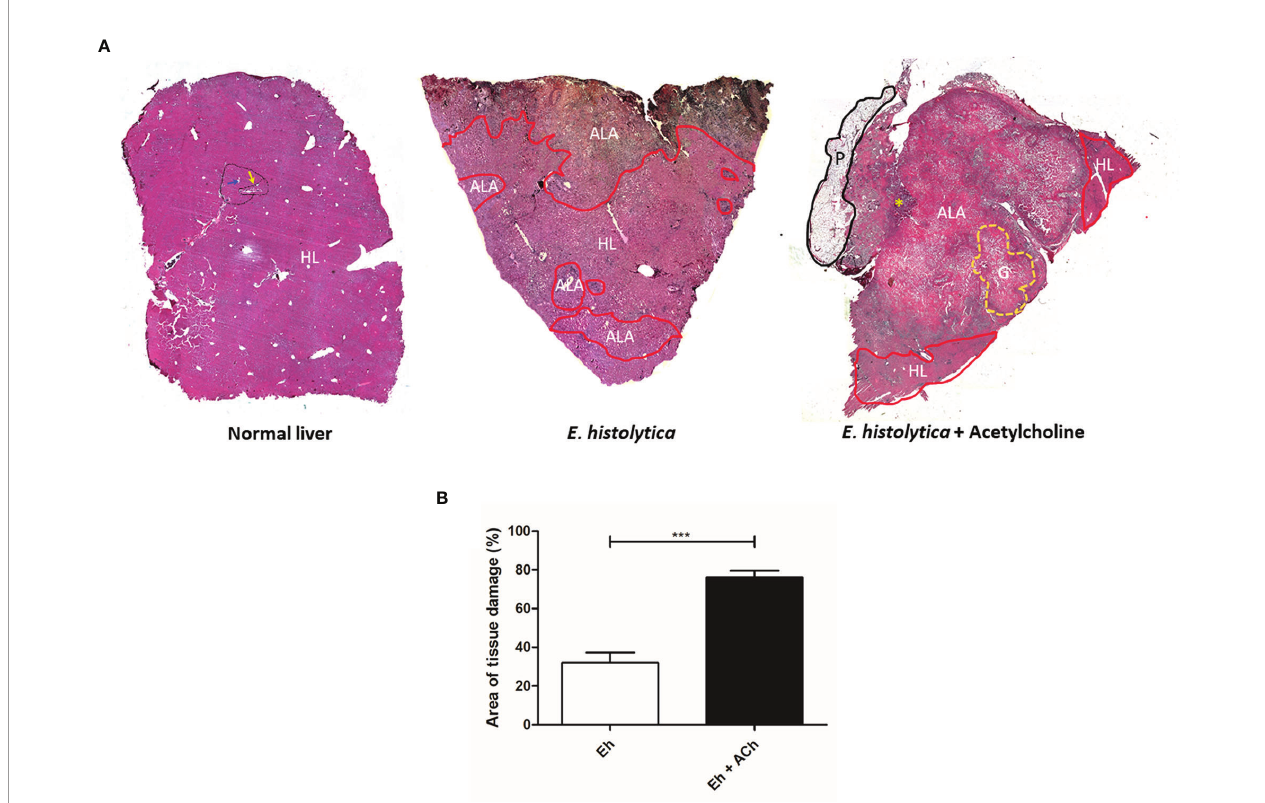
FIGURE 11 | Damage of hepatic tissue caused by acetylcholine-activated E. histolytica trophozoites. (A) Histological structure of a hamster liver with normal hepatic characteristics (black line), delimited by portal triads (yellow arrow) and the presence of centrilobular veins (blue arrow). Liver damaged by E. histolytica. The area of healthy liver tissue is located at the central part of the histological section. Areas damaged by trophozoites (red line) located in the periphery, representing 32.01 % ± 18.4 of the liver. Liver damaged by ACh-treated trophozoites. The area of damage is very wide, covering about 76.1 % ± 7.5 of the analyzed tissue. In addition, granulomas (yellow line) and large areas of necrosis with hemorrhage are shown on the left side, an area of abscess opening (yellow asterisk) was observed, and the adjacent peritoneum (black line) formed a barrier likely avoiding the dissemination of purulent content. HL, Healthy Liver; ALA, Amebic Liver Abscess; G, Granuloma; P, Peritoneum. (B) Percentage of tissue damage on hamster livers by E. histolytica and E. histolytica treated with ACh. The statistical analysis was performed with Student's t test, where the values of ***p < 0.001 were considered signi fi